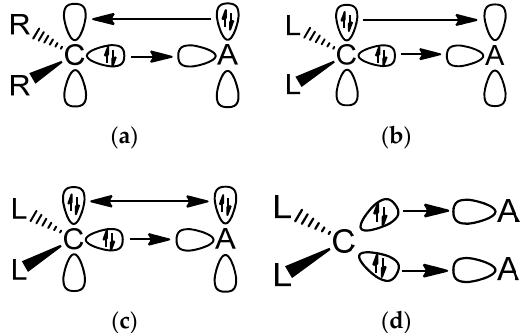
Figure 1. Schematic representation of the most important orbital interactions between carbene ligands CR 2 and carbones CL 2 with Lewis acids A.( a ) Carbene complex with a monodentate Lewis acid; ( b ) Carbone with a bidentate Lewis acid; ( c ) Carbone with a monodentate Lewis acid; ( d ) Carbone with two monodentate Lewis acids.